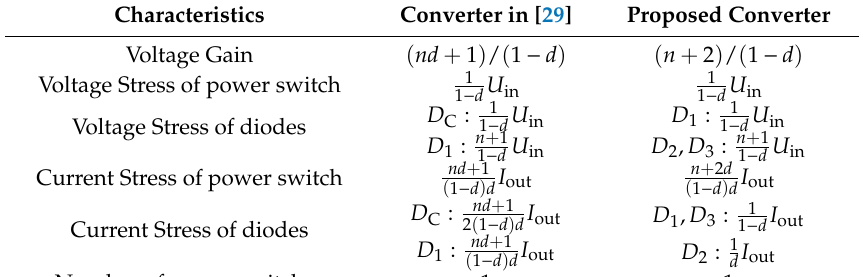
Table 1. Comparisons of two types of converters with input current ripple minimization. Figure 4. The current distribution in different states: ( a ) Q is turned on; ( b ) Q is turned off.